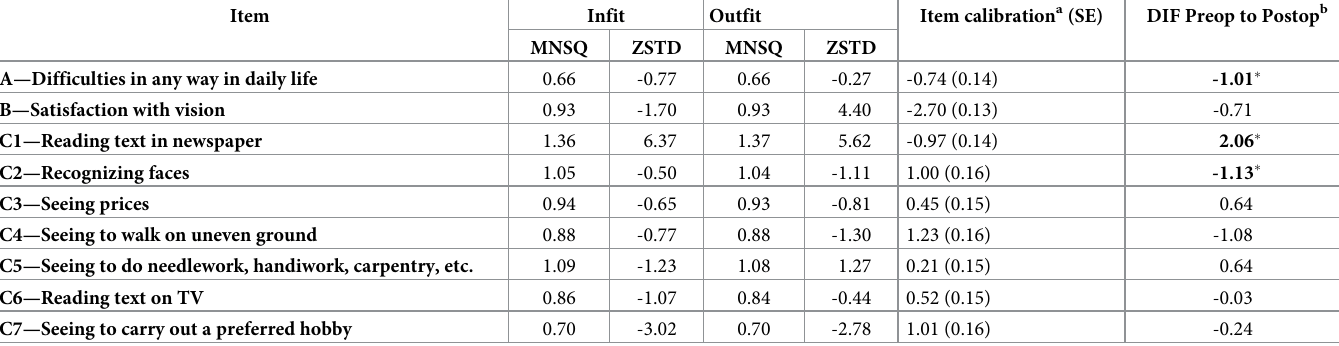
Table 2. Item fit statistics for the